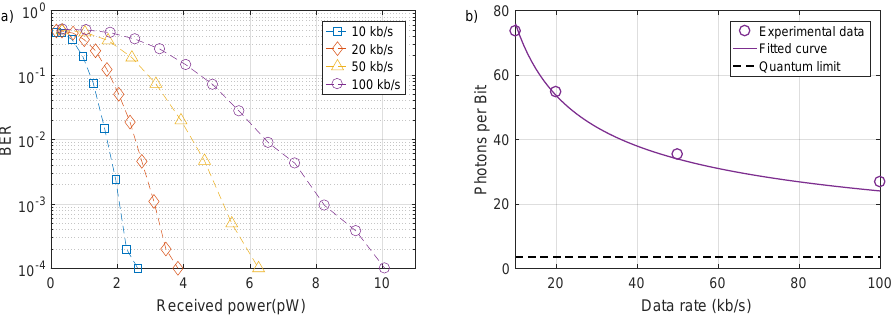
Figure 4. ( a ) BER as a function of received signal power for varying data rates. ( b ) Received photons per bit required to achieve a BER of less than 10 − 3 for varying data rates, fitted with a x − 1 2 relationship. The standard quantum limit for OOK at this BER is also